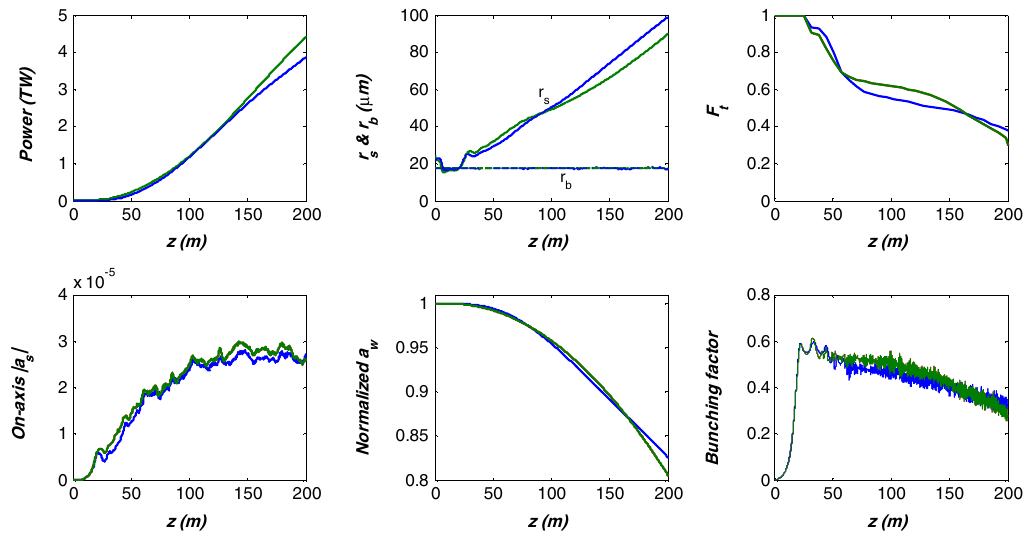
j , r , F , and bunching factor in a s s t